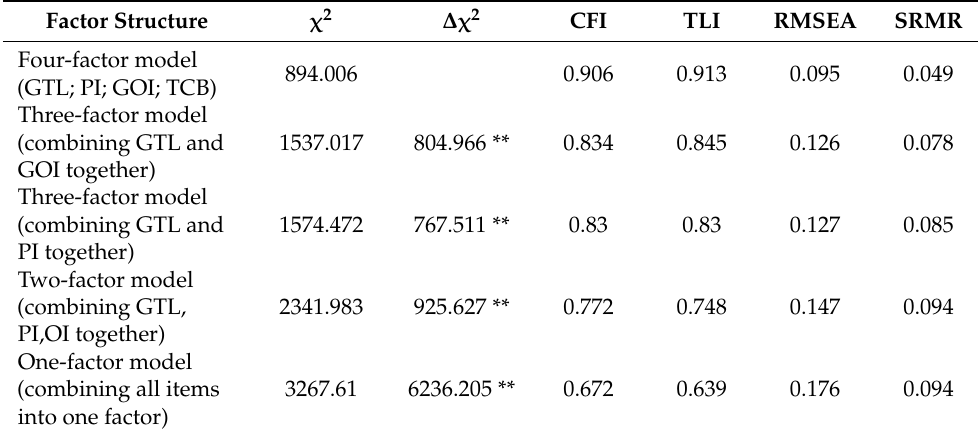
Table 2. Confirmatory factor